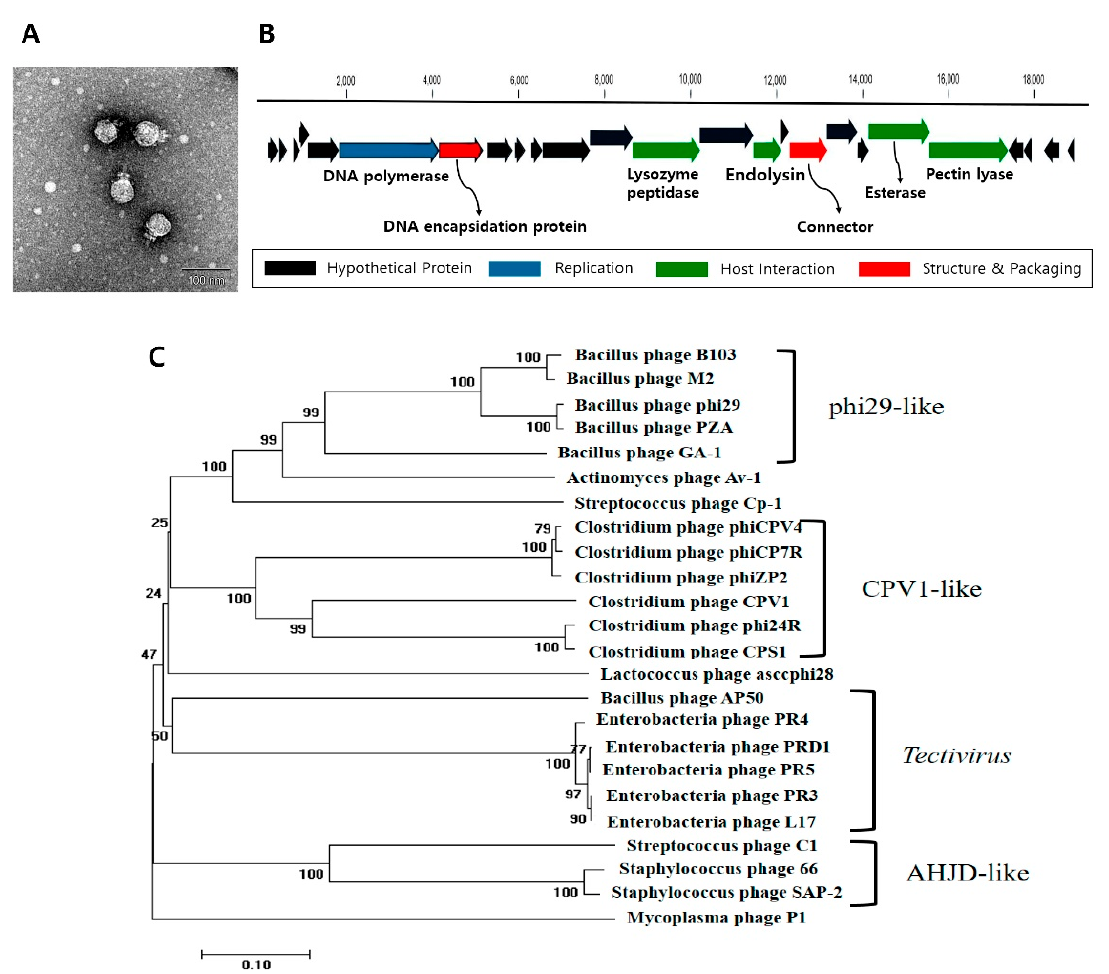
Figure 1. C. perfringens bacteriophage capsular polysaccharides (CPS)1 has Picovirinae characteristics. ( A ) TEM image of C. perfringens phage CPS1. The scale bar indicates 100 nm. ( B ) Genome map of CPS1. Red: structure and packaging, blue: DNA manipulation, green: host lysis, black: hypothetical protein. Twenty-five putative open reading frames (ORFs) were predicted in the CPS1 genome. ( C ) Phylogenetic tree showing the relationship between CPS1 and other Picovirinae phages based on type-B DNA polymerase comparisons.